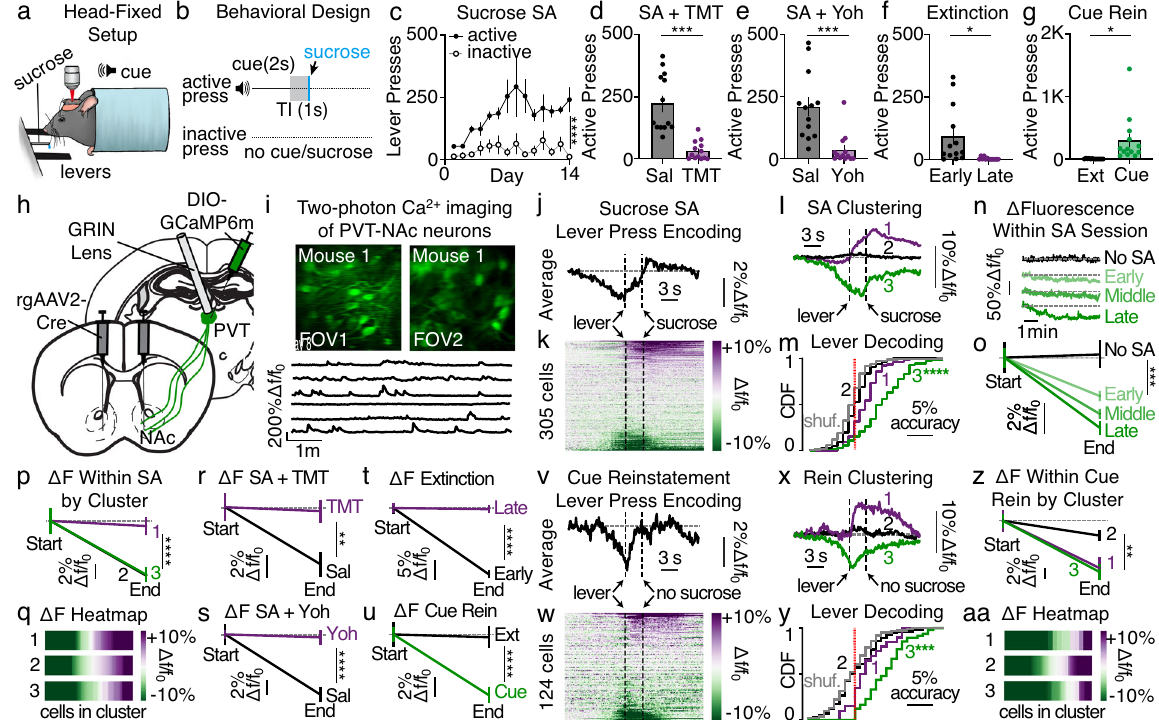
Fig. 1 | Inhibition of select PVT → NAc neuronal ensembles predicts sucrose self-administration and seeking. a – c Behavioral design ( a ; image modi fi ed from Vollmer et al., 2021 71 ), schematic ( b ), and grouped data ( c ) for sucrose self- administration ( n =13 mice; two-way ANOVA, lever: F 1,24 =60.65, P <0.001). d – f TMT ( d ), yohimbine ( e ), and extinction ( f ) suppressed lever pressing ( n =13 mice; TMT: two-tailed t -test t 12 =5.54, P =0.001; yohimbine: t 12 =5.66, P =0.001; extinction: t 12 =2.72, P =0.02). g Cue presentation provoked reinstatement after extinction ( n =13 mice; t 12 =2.79, P =0.02). h , i Surgery ( h ) for visualization of PVT → NAc neurons ( i ; top) and calcium-mediated fl uorescent signals ( i ; bottom). j , k Averaged trace ( j ) and single-cell heatmap ( k ) revealing PVT → NAc dynamics during sucrose self-administration ( n =6 mice, 305 cells). l Clustering revealed three PVT → NAc neuronal ensembles during sucrose self-administration: excitatory (purple,79cells),non-responding(black,153cells),andinhibitory(green,73cells). m Active lever press decoding was most accurate for ensemble 3 during self- administration (two-way ANOVA, ensemble × shuf fl e interaction: F 2,604 =34.02, P <0.001; Sidak ’ s post-hoc: P s<0.001). n , o Example waveforms ( n ) and grouped data ( o ) showing reduced PVT → NAc activity during self-administration but not a baseline (No-SA) session ( n =3 – 6 mice, 105 – 327neurons; two-wayANOVA, session × time: F 3,2116 =5.19, P =0.001; Sidak ’ s post-hoc: No-SA vs. other sessions, P- values<0.002). p , q Grouped data ( p ) and heatmap ( q ) reveal